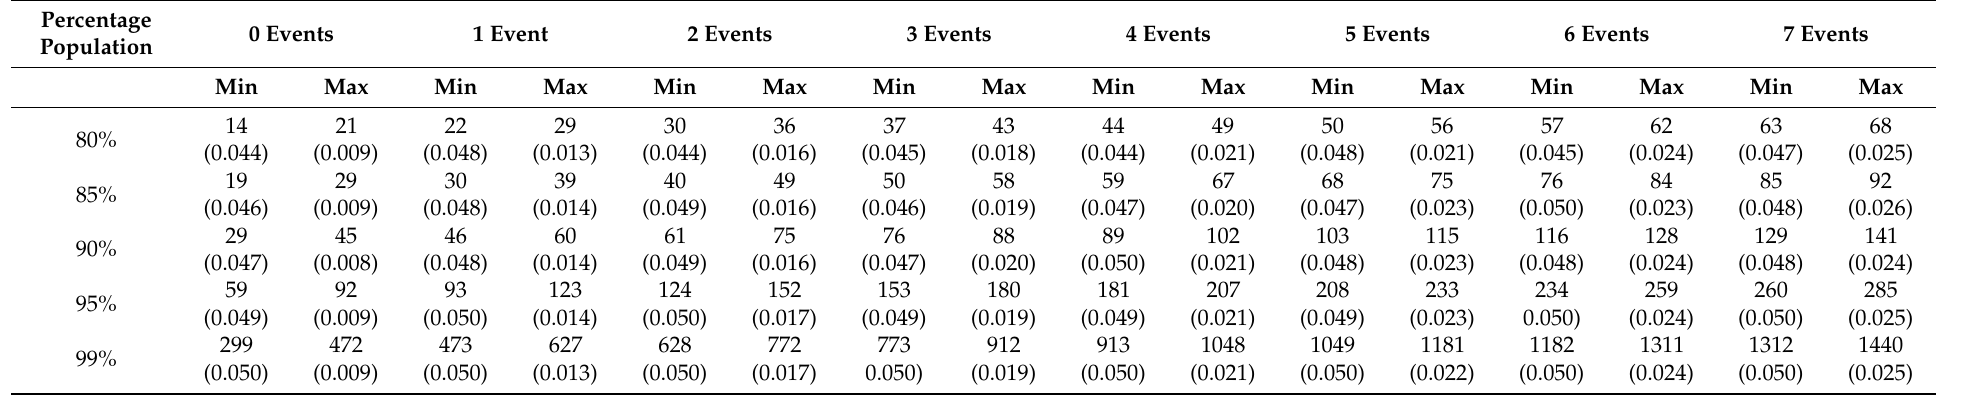
Table 1. Minimum and maximum required sample size with error probabilities for 0 up to 7 uncontrollable events for five different